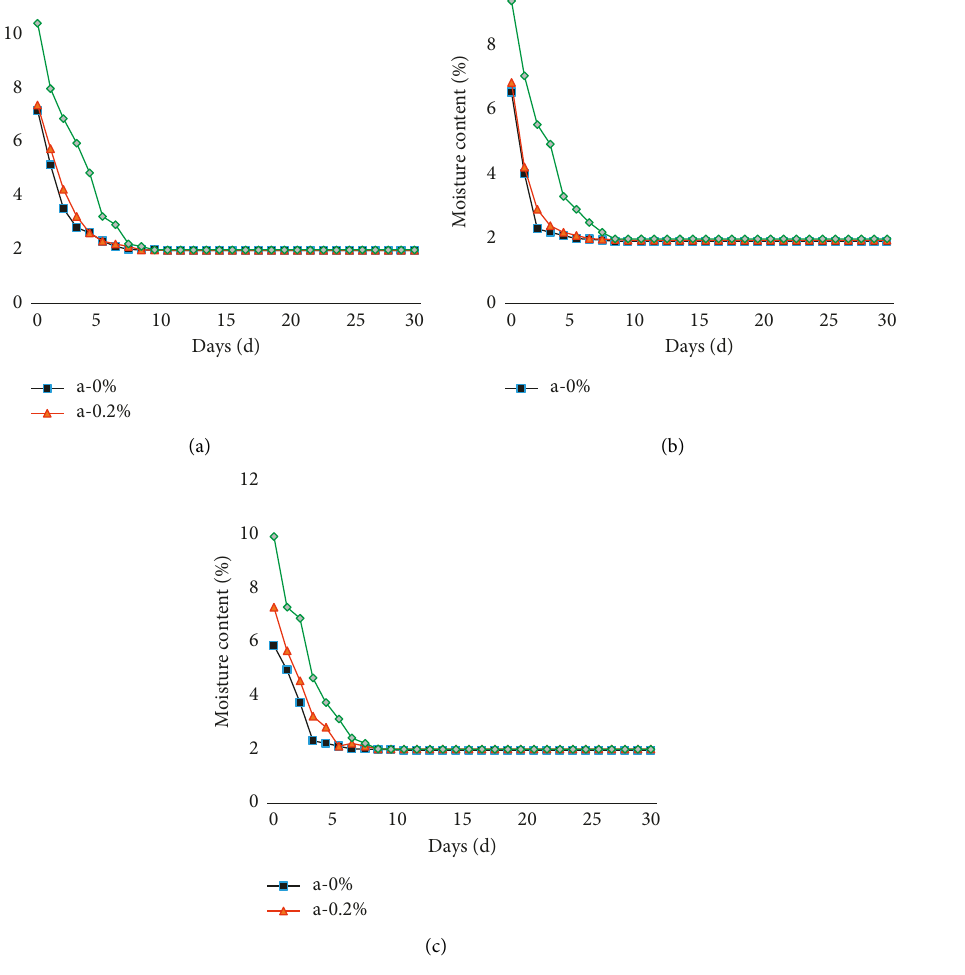
Figure 3(a): 1.55 g/cm 3 sample hardness change curve